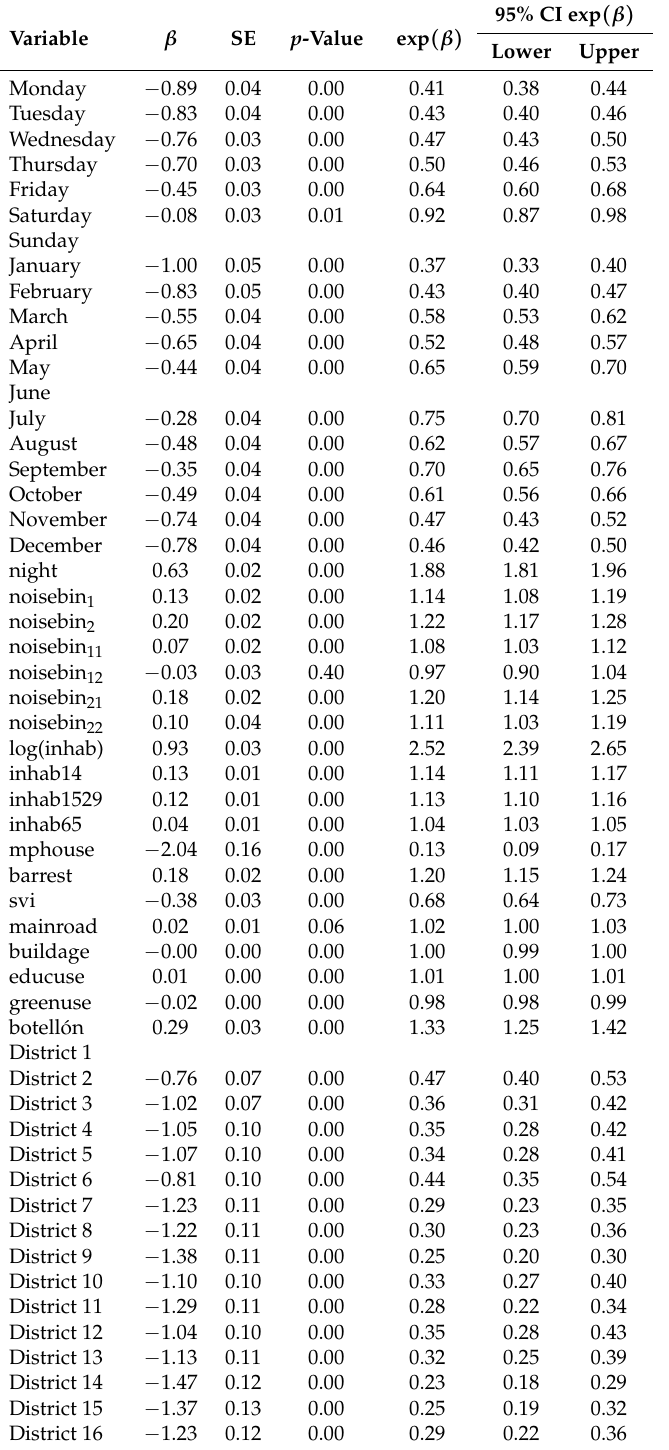
Table 3. Results of the logistic